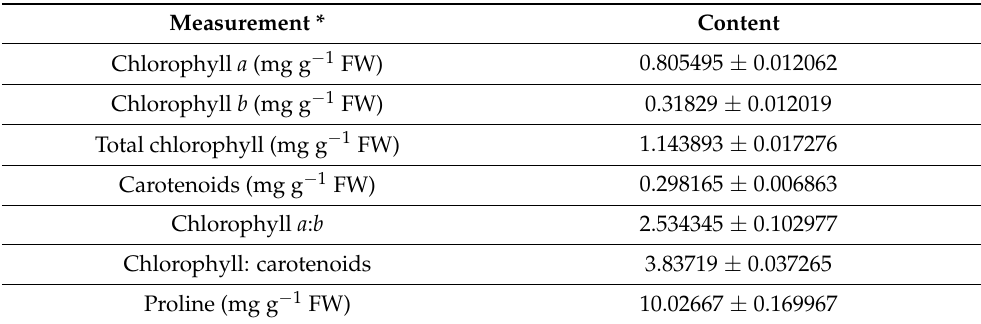
Table 8. Chlorophyll a , chlorophyll b , carotenoids and proline content of S. diversifolia leaves, * ( n =